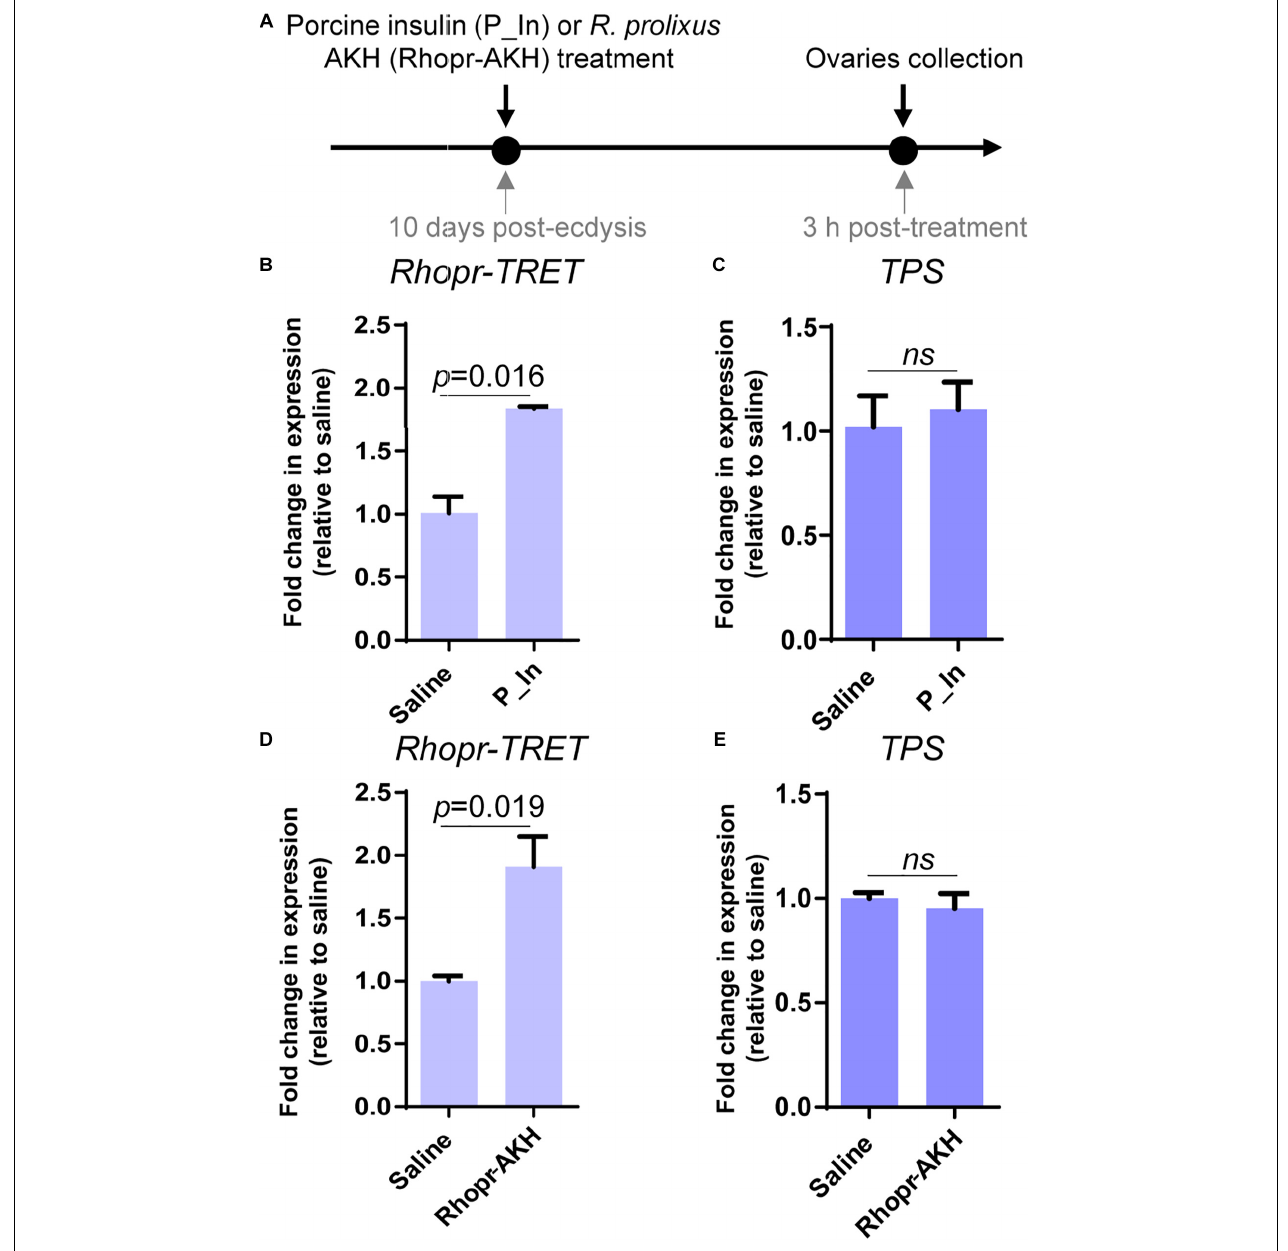
FIGURE 5 | Participation of insulin and AKH signaling in Rhopr-TRET mRNA expression using in vivo assays. (A) Experimental scheme for (B–E) . (B) Rhopr-TRET transcript expression after P_In injection; (C) TPS transcript expression after P_In injection; (D) Rhopr-TRET transcript expression after Rhopr-AKH injection. (E) TPS transcript expression after Rhopr-AKH injection. Rhopr-TRET and TPS transcript expression in ovaries of unfed adult females was tested by RT-qPCR. The y -axis represents the fold change in expression relative to control (saline, value ∼ 1). The results are shown as the mean ± SEM ( n = 3–4, where each n represents a pool of tissues from 2 insects). Statistically significant differences were determined by the Student’s t -test.